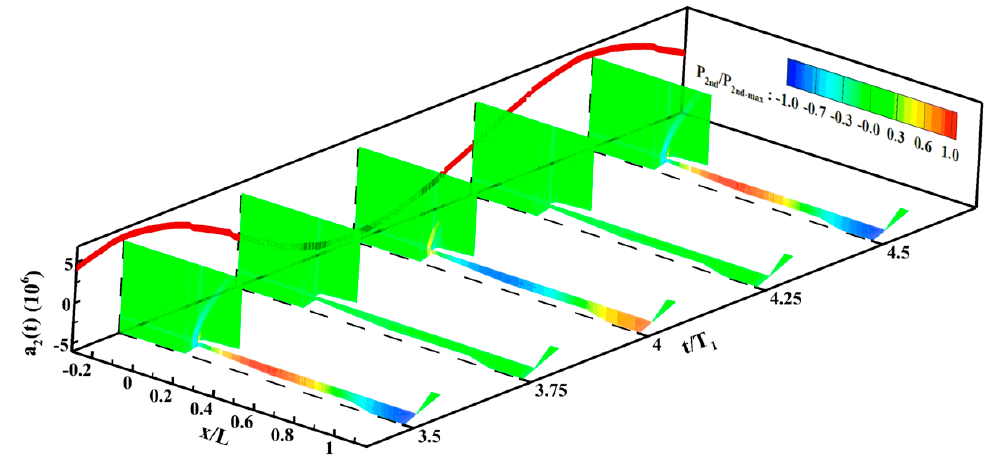
Figure 12. Static pressure fluctuation field of second-order POD mode during one buzz cycle.